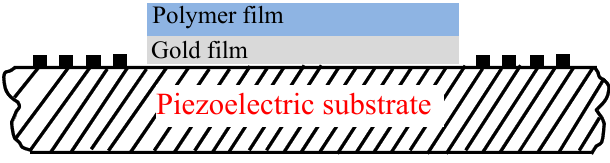
Figure 2. The schematic of the sensor structure and coordination system in this study.